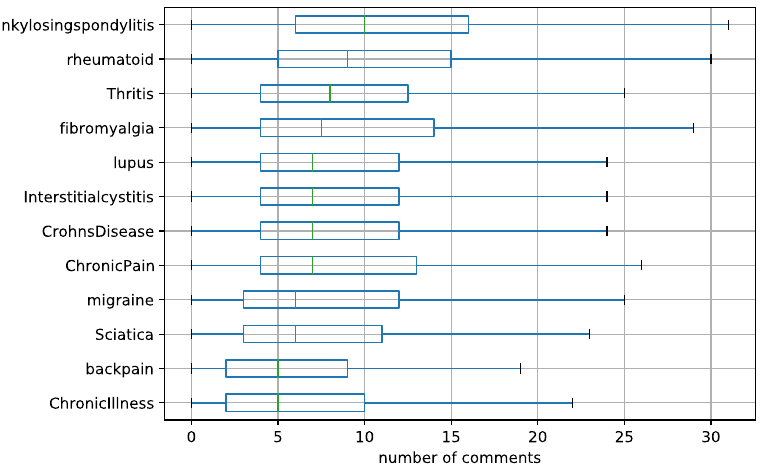
Figure A3. Distribution of the number of comments per submission (outliers are omitted).